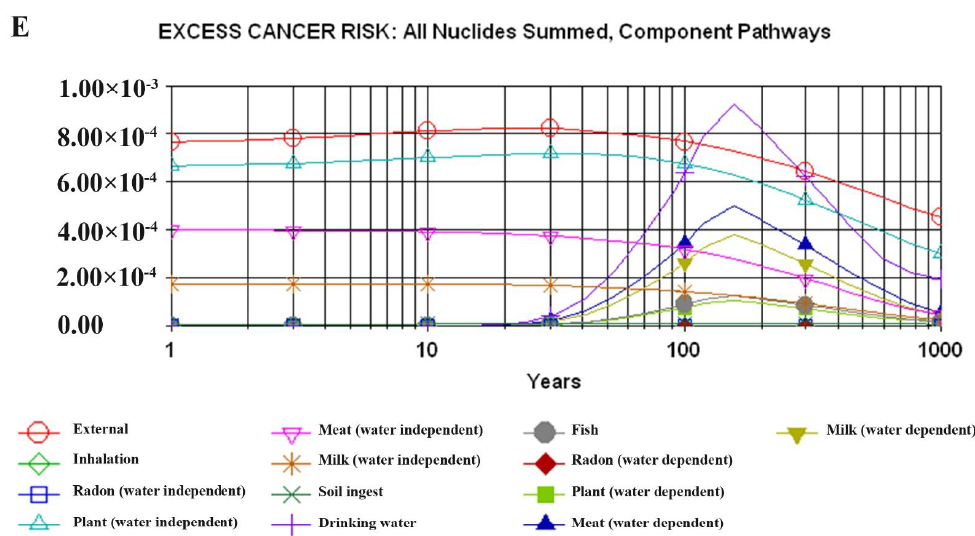
Figure 5. Contribution of the different exposure pathways to cancer risk. ( A ) Ajka coal, ( B ) Ajka red mud, ( C ) Almásfüzitő red mud, ( D ) Zalatárnok drilling mud, ( E ) Ú rkút manganese. Figure 6 shows the dose rates for all isotopes and exposure pathways for an assumed 1 m thick cover. In general, the dose is significantly reduced by the application of the cover. The doses from Ra-226 and Th-232 decreased to zero in the first 100 years, for K-40 except at the Ajka red mud reservoir. The dose of potassium starts to increase between 30 and 50 years. After 100 years, the contribution of K-40 decreases, while the exposure to Th-232 and Ra-226 starts to increase significantly.